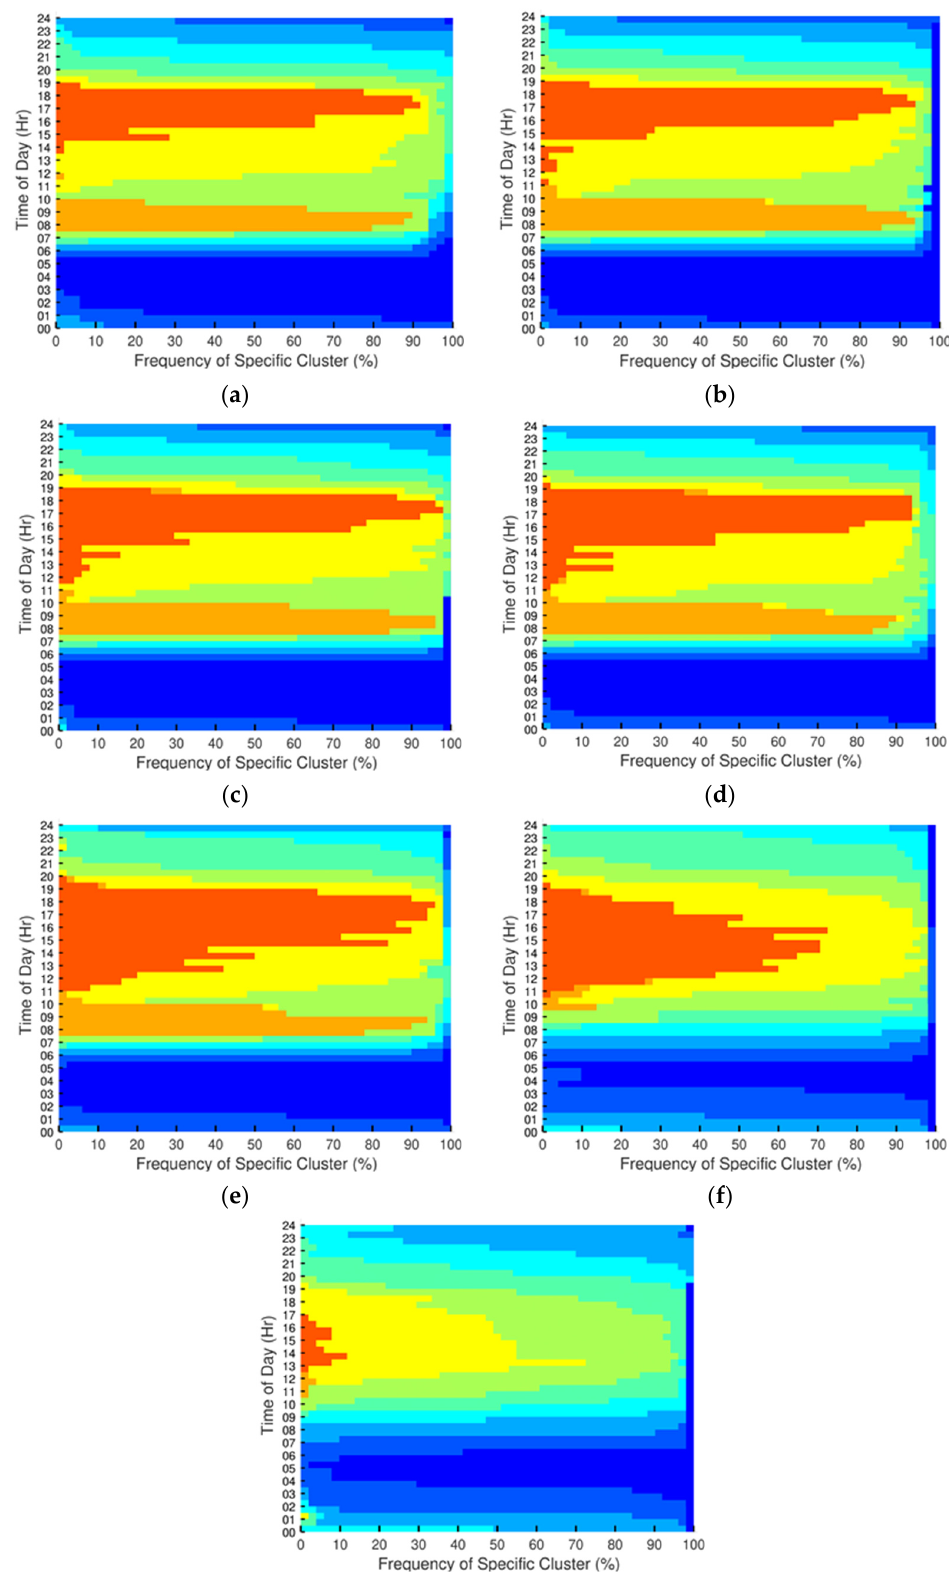
Figure 7. Spatial characteristics of projected volume profiles; ( a ) Monday; ( b ) Tuesday; ( c ) Wednesday; ( d ) Thursday; ( e ) Friday; ( f ) Saturday; ( g ) Sunday.